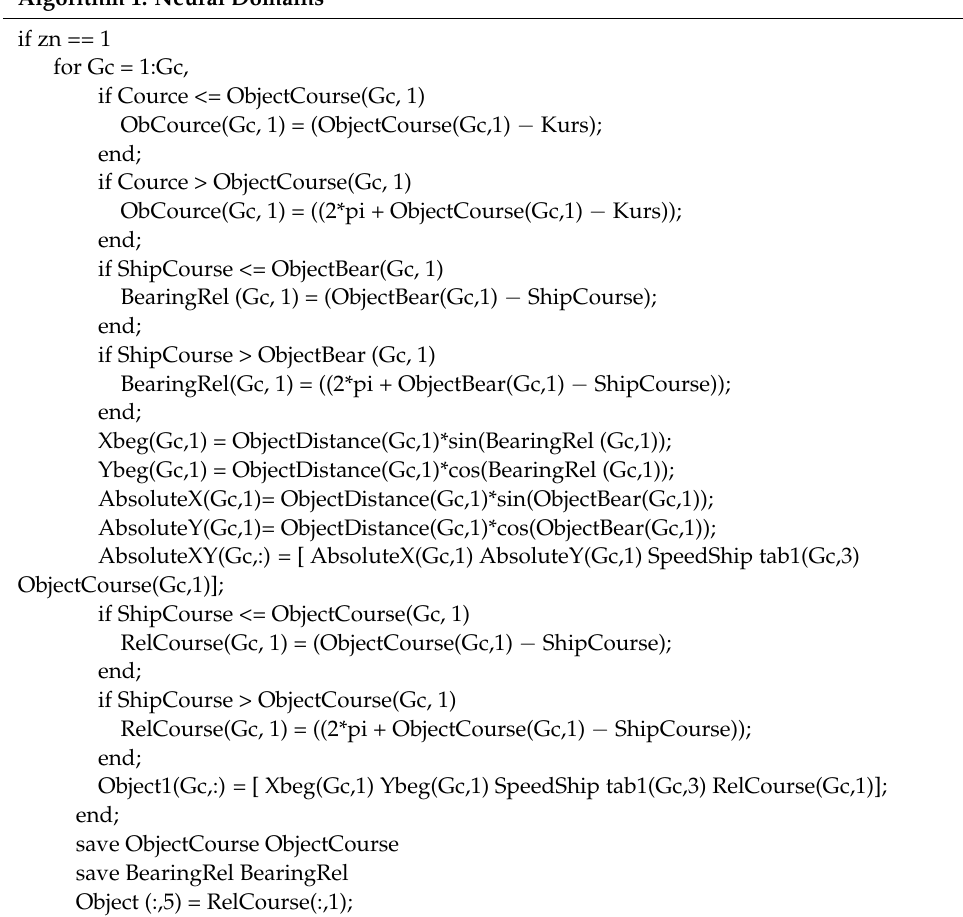
Algorithm 1: Neural